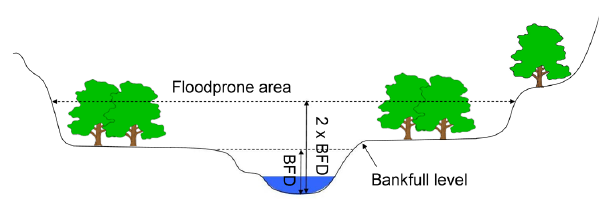
Fig. 3. Floodplain cross-section defining the geomorphological pa- rameters in which the BFD approach relies